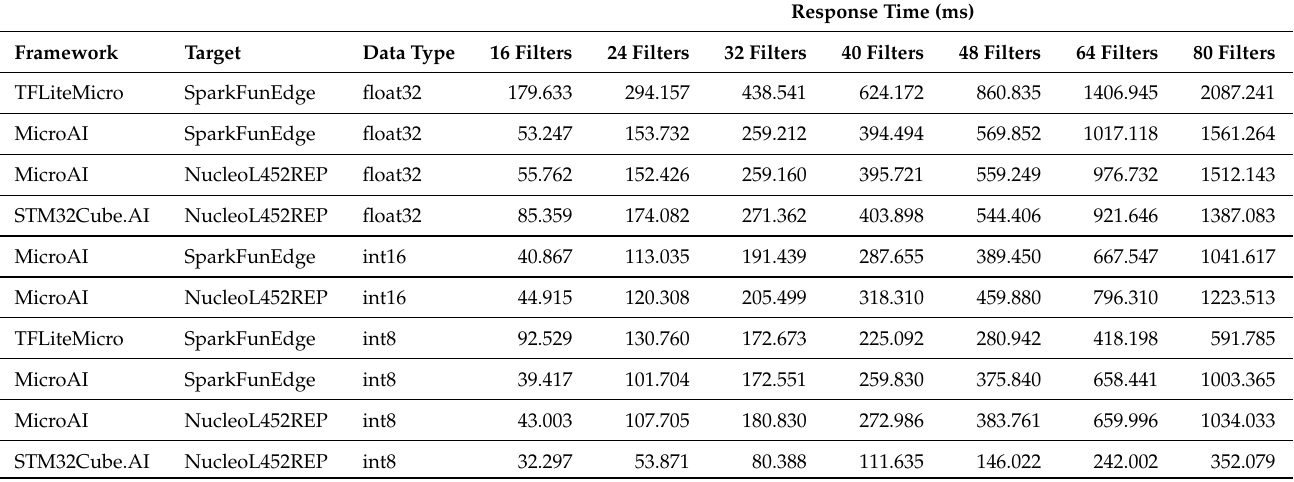
Table A4. Inference time for one input vs. filters for TFLite Micro, STM32Cube.AI and